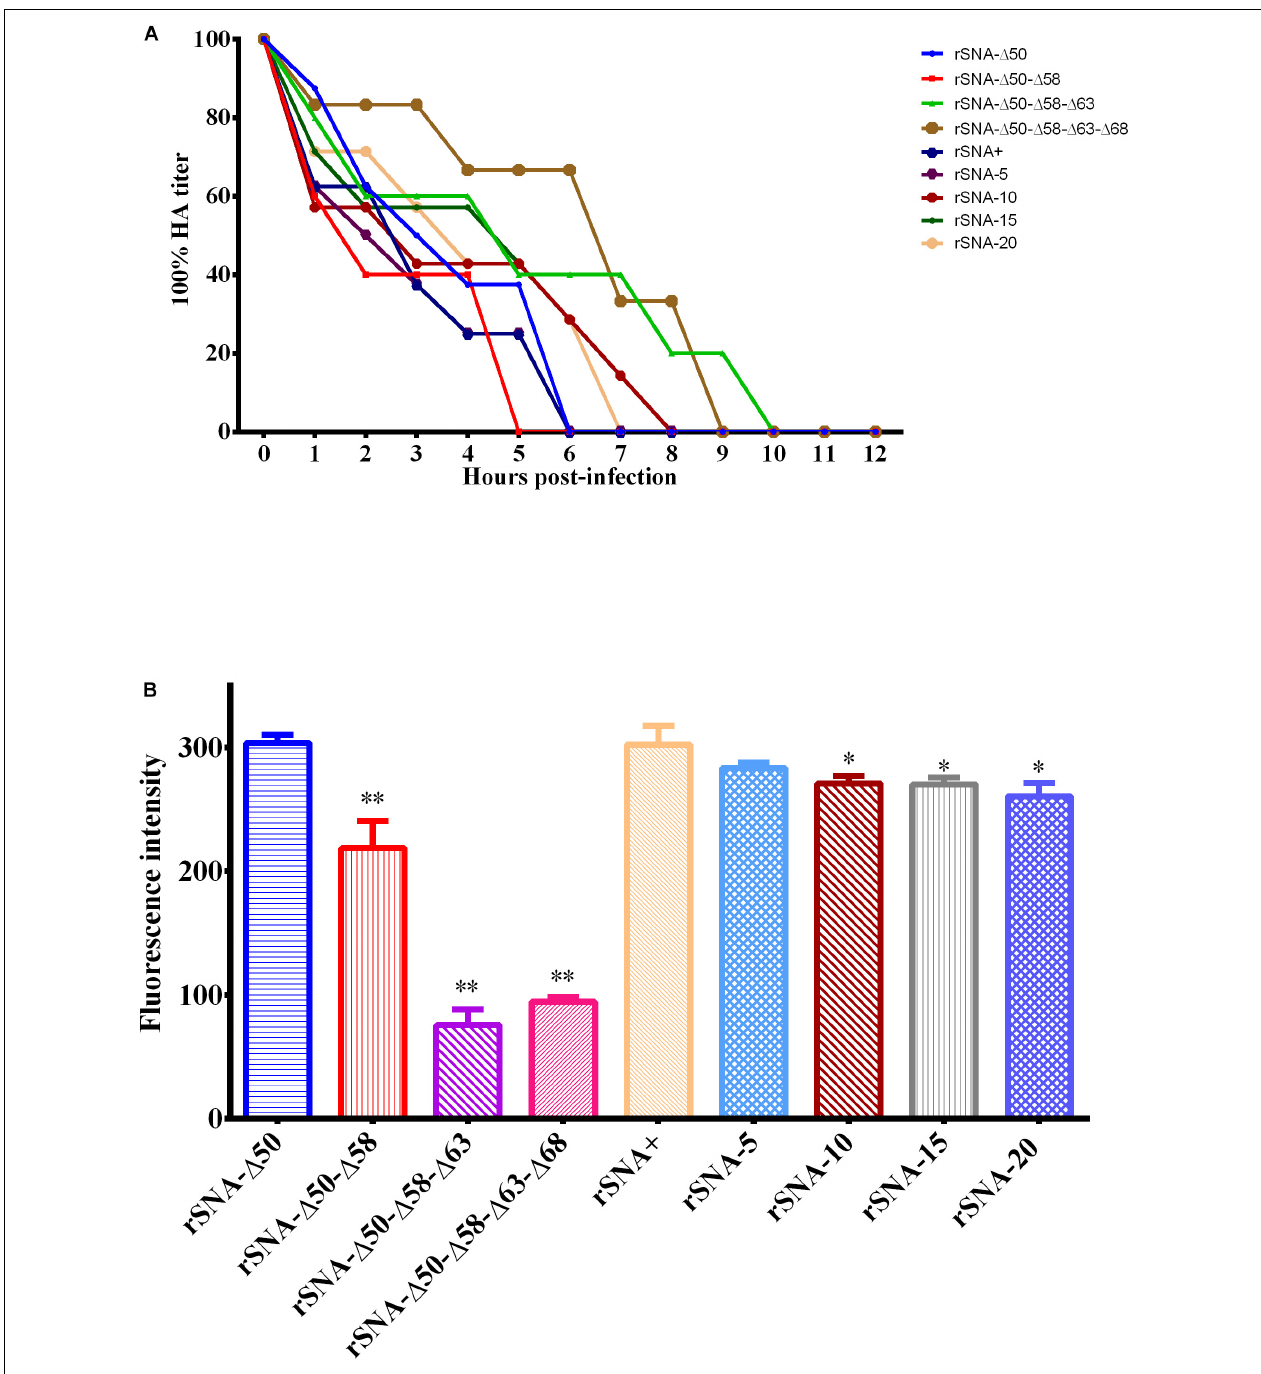
FIGURE 5 | Curves of the recombinant viruses released from the red blood cell surface (A) and neuraminidase activity assays of them (B) . * P < 0.05, ** P < 0.01, compared to the value of the rSNA +